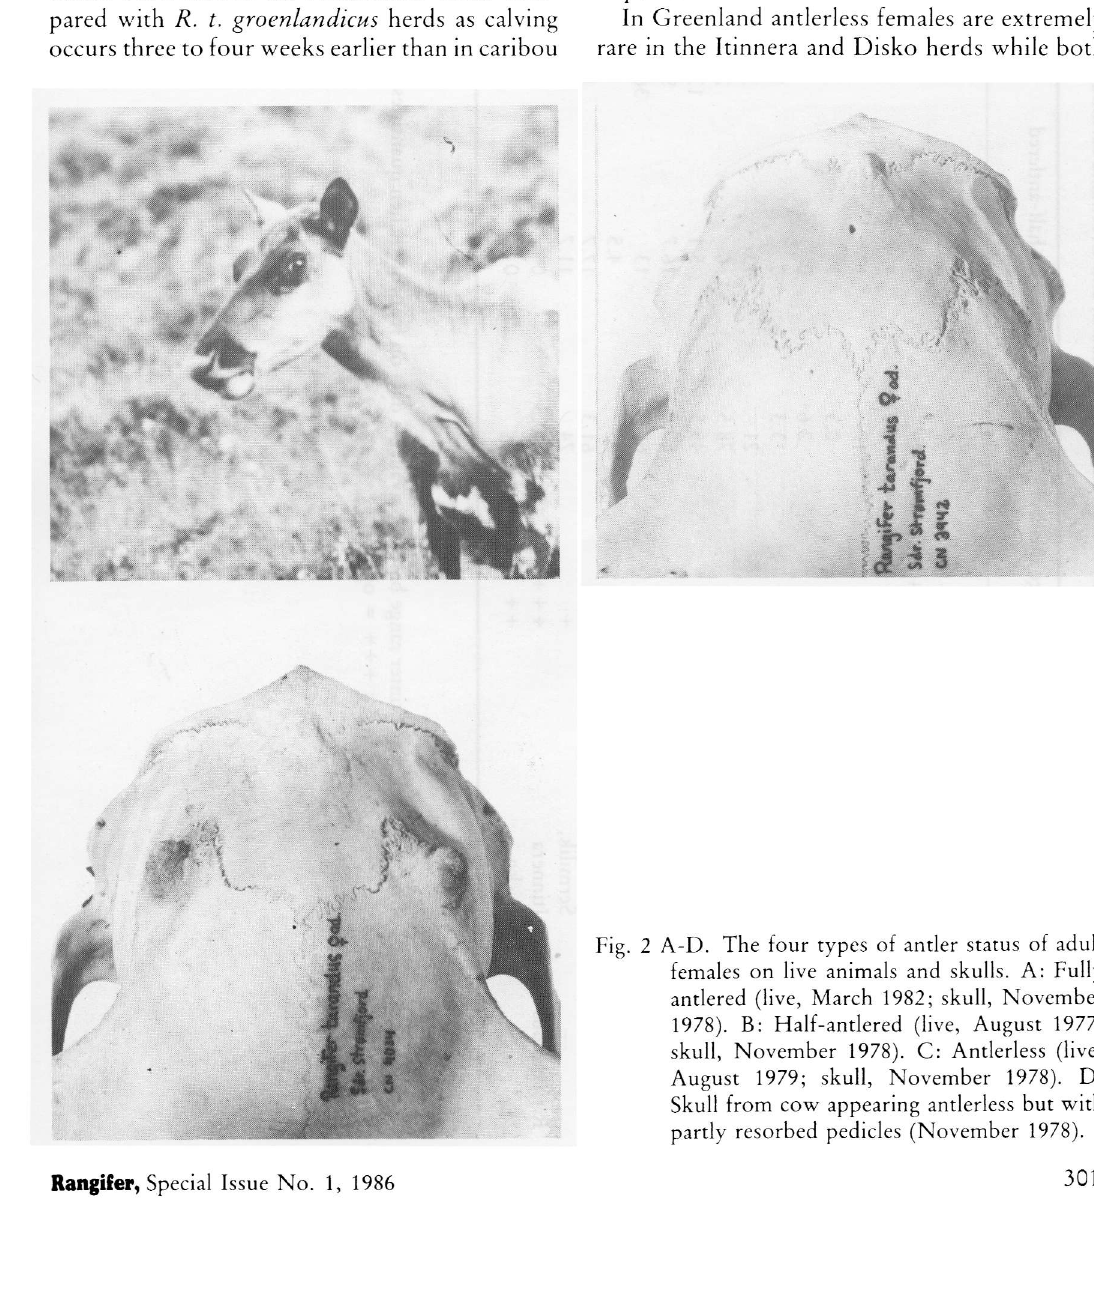
Fig. 2 A-D. The four types of antler status of adult females on live animals and skulls. A: Fully antlered (live, March 1982; skull, November 1978). B: Half-antlered (live, August 1977; skull, November 1978). C: Antlerless (live, August 1979; skull, November 1978). D: Skull from cow appearing antlerless but with partly resorbed pedicles (November